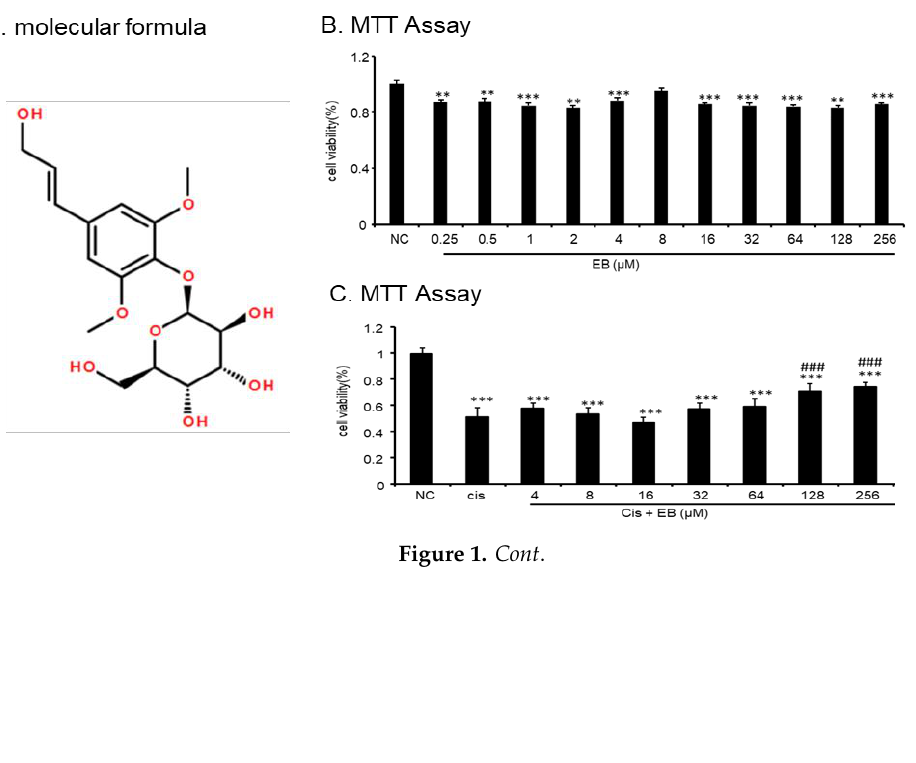
Figure 1. Effect of eleutheroside B on cell viability and kidney injury molecule-1 (KIM-1) levels with or without cisplatin treatment. ( A ) Molecular structure of eleutheroside B. ( B ) Effect of different concentrations of eleutheroside B on viability of human kidney-2 (HK-2) cells by MTT assay. ( C ) Eleutheroside B restored cell viability in cisplatin-treated HK-2 cells by MTT assay. ( D ) Immunofluorescence of KIM-1 in HK-2 cells. Eleutheroside B treatment significantly reduced the protein level of KIM-1 in cisplatin-treated HK-2 cells. ( E ) Western blot analysis of KIM-1 protein in HK-2 cells. ( F ) Real-time PCR in HK-2 cells. Eleutheroside B significantly decreased cisplatin-induced mRNA level of KIM-1. Data represent the mean ± SEM for 3 – 4 independent experiments in vitro. ** p < 0.05, ** p < 0.01, *** p < 0.001 versus normal; # p < 0.05, ## p < 0.01, ### p < 0.001 compared to cisplatin-treated group. Cis, cisplatin. 2.2. Effects of Eleutheroside B on Inflammatory Cytokines Induced by Cisplatin in HK-2 Cells Cisplatin-induced inflammation caused an increase in the levels of a variety of inflammatory cytokines via the activation of the nuclear factor κB (NF - κB) intracellular signaling pathways. The activation of NF- κB i n the classical inflammatory pathway is associated with the inflammatory response of AKI, thus the detection of NF- κB is necessary. Western blot analysis showed that eleutheroside B reduced the expression of cisplatin-induced activated p-P65 ( ## p < 0.01) (Figure 2A).